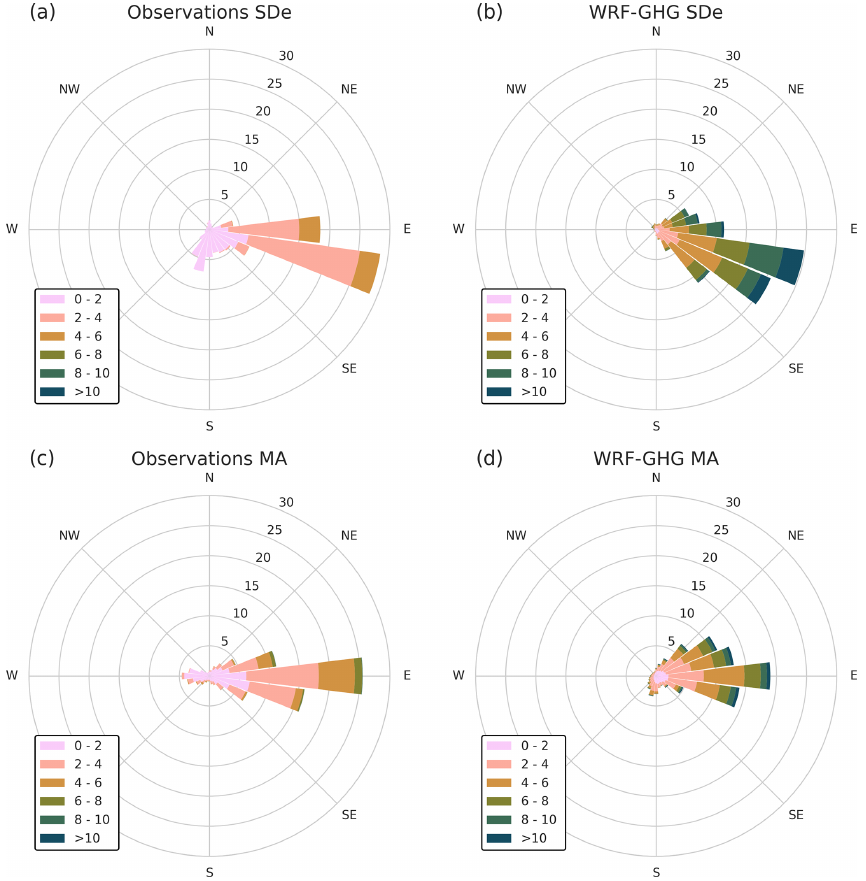
Figure 4. Wind rose from observations and WRF-GHG simulations at SDe (a–b) and at MA (c–d) . The colors indicate the associated wind speed (in ms − 1 ), while the lengths of the bars show the frequency of any wind direction binned by 15 ◦ , given in percentage.